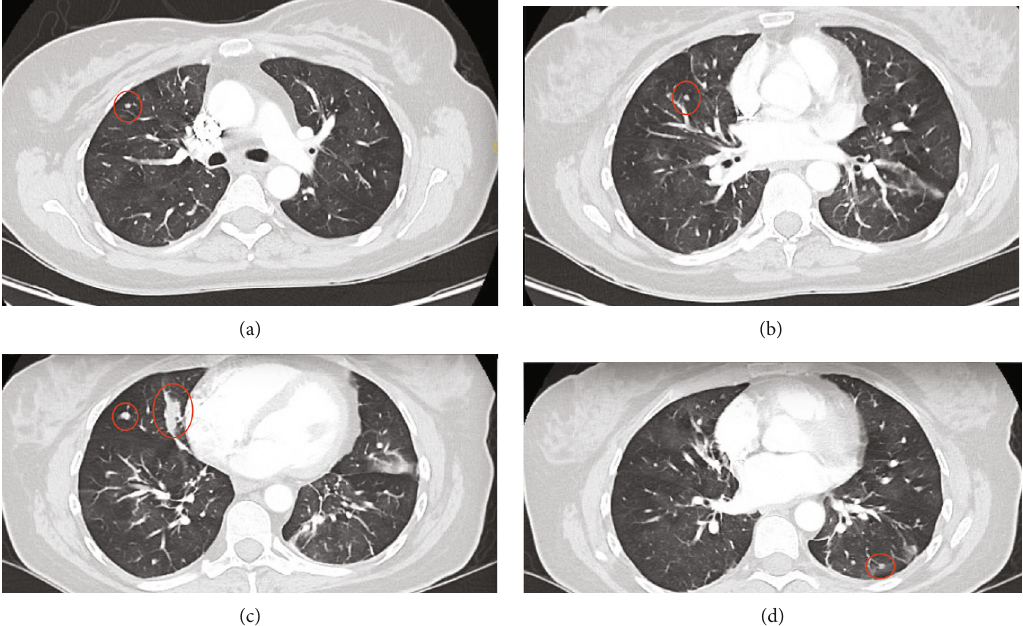
Figure 1: CT chest with di ff use mosaic attenuation and multiple pulmonary nodules: (a) 4 mm right upper lobe nodule; (b) 4mm right middle lobe nodule; (c) 7 mm lateral right middle lobe nodule with con fl uent 1.8cm medial right middle lobe nodule; (d) 4 mm left lower lobe nodule.